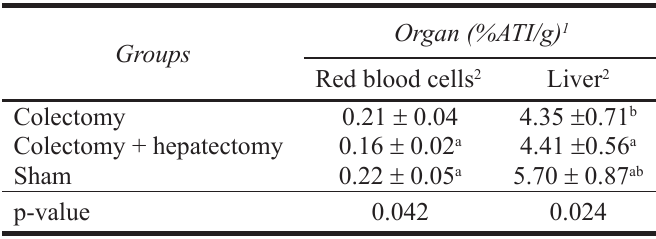
TABLE 1 - 99m Tc-phytate biodistribution studies for each group.